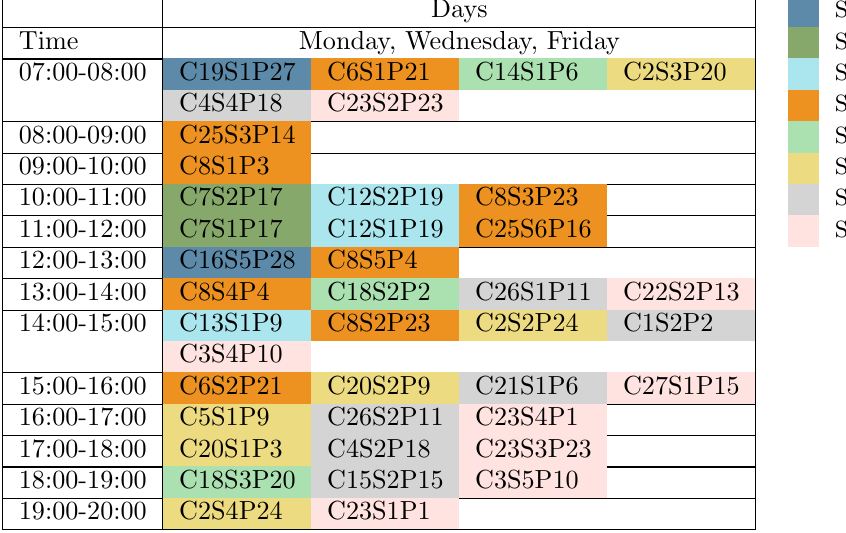
Figure 8. Timetable of fourth strategy for courses in day scheme A: Monday, Wednesday and Friday, three classes of 1 h per week.